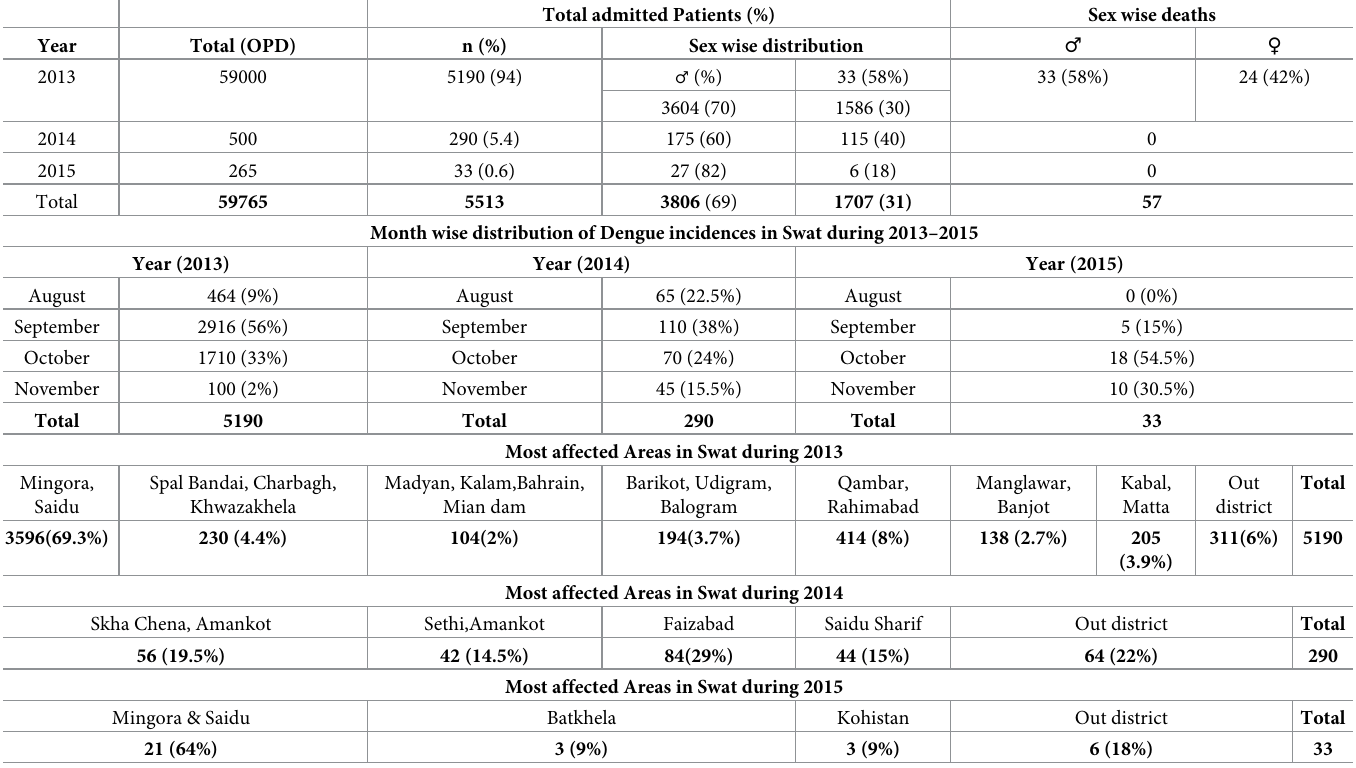
Table 2. Month, sex and area wise distribution of dengue